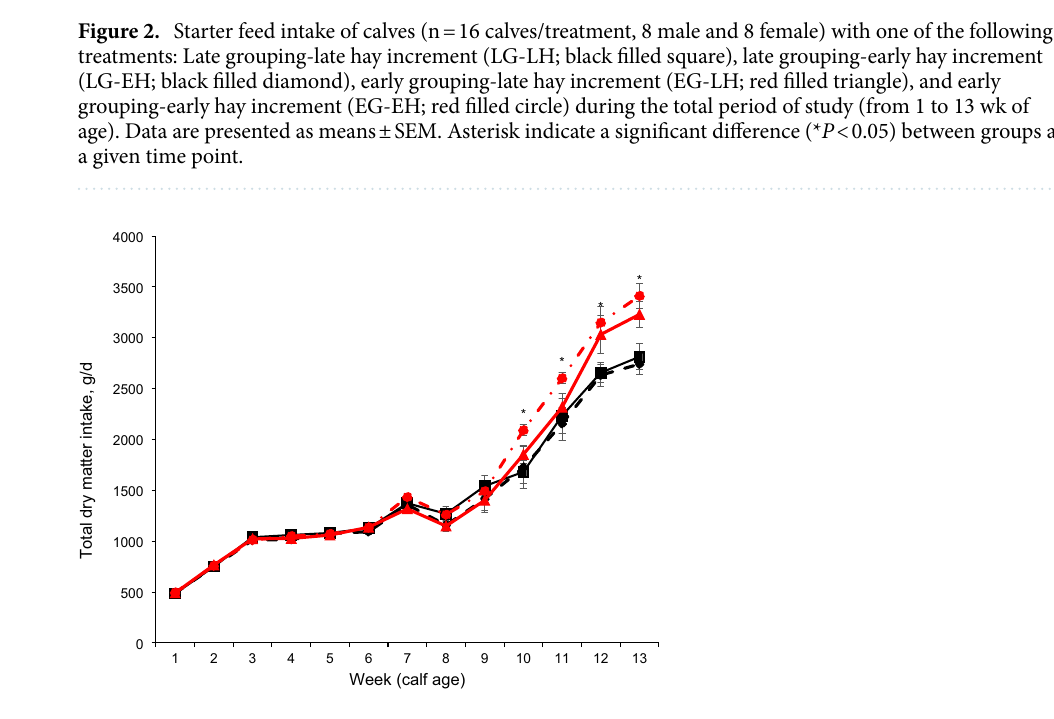
Figure 3. Total dry matter intake of calves (n = 16 calves/treatment, 8 male and 8 female) with one of the following treatments: Late grouping-late hay increment (LG-LH; black filled square), late grouping-early hay increment (LG-EH; black filled diamond), early grouping-late hay increment (EG-LH; red filled triangle), and early grouping-early hay increment (EG-EH; red filled circle) during the total period of study (from 1 to 13 wk of age). Data are presented as means ± SEM. Asterisk indicate a significant difference (* P < 0.05) between groups at a given time